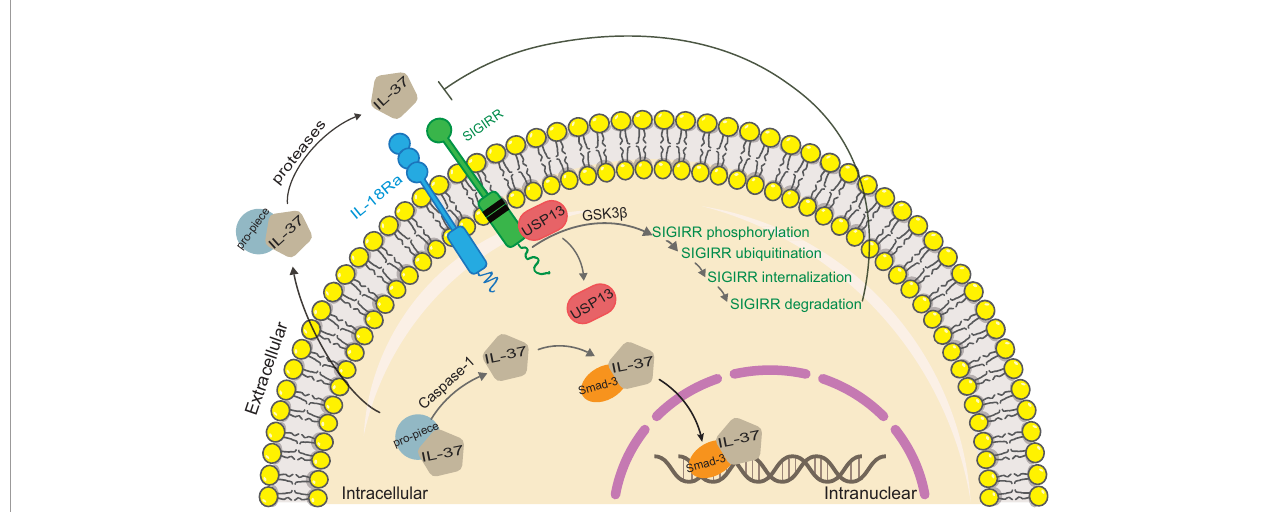
FIGURE 2 | Functional mechanisms of IL-37. IL-37 is a dual function cytokine. As regard the intracellular activity of IL-37, the pro-in fl ammatory stimuli increase the production of intracellular IL-37 precursor, and trigger the activation of caspase-1, which in turn cleaves IL-37 precursor into mature IL-37. Mature IL-37 binds to phosphorylated Smad-3, forming a complex that translocates into the nucleus, where it regulates gene expression. As regard the extracellular activity of IL-37, both mature and precursor forms of IL-37 are secreted by an unknown mechanism. Extracellular proteases process IL-37 precursor outside the cell, which in turn binds with IL-18R a and recruits IL-1R8 to form complex exerting the extracellular function of IL-37. IL ‐ 37 induced activation of GSK3 b , which plays a role of feedback control of IL ‐ 1R8/Sigirr abundance. Activation of GSK 3 b promotes Sigirr phosphorylation, ubiquitination, internalization, and degradation through disrupting Sigirr association with